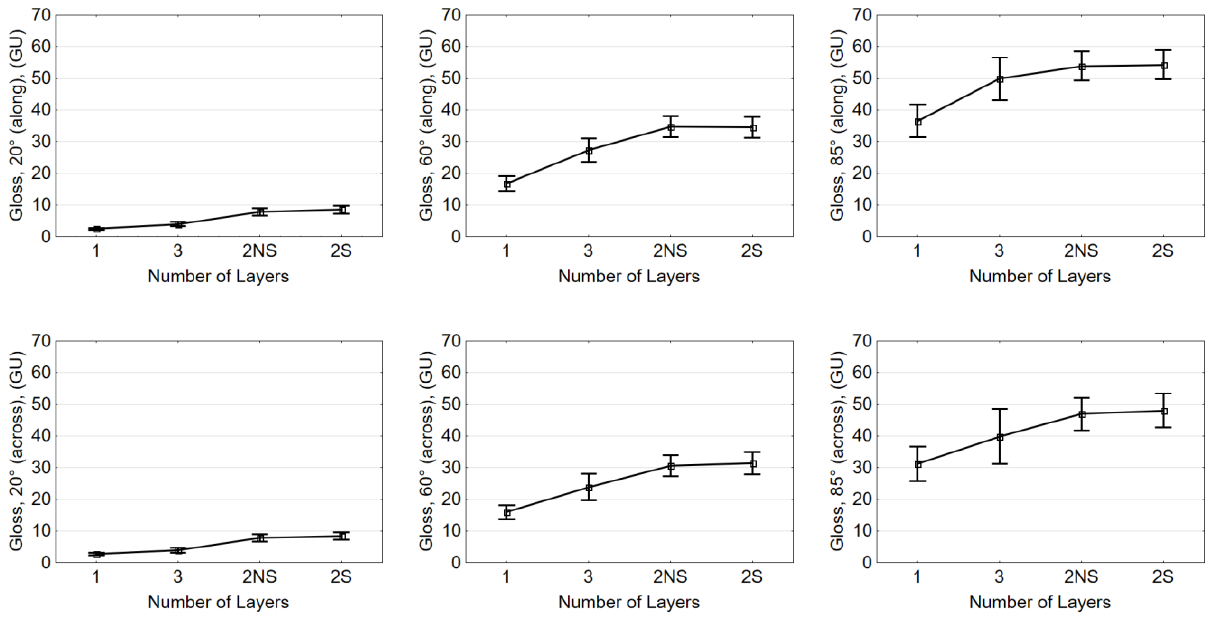
Figure 5. Main effects plot for mean gloss for different numbers of layers for each measurement